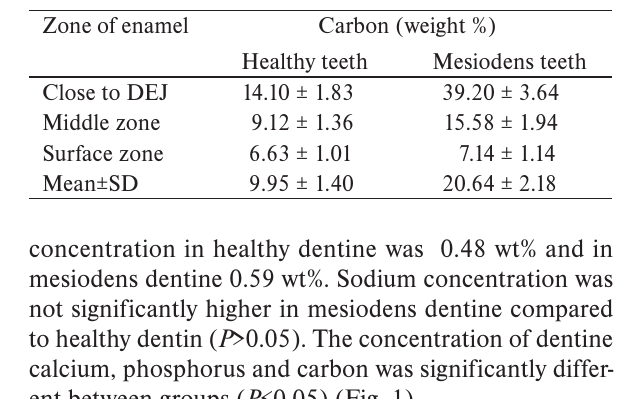
Table 2. Carbon content in wt% in different zone of enamel of healthy and mesiodens